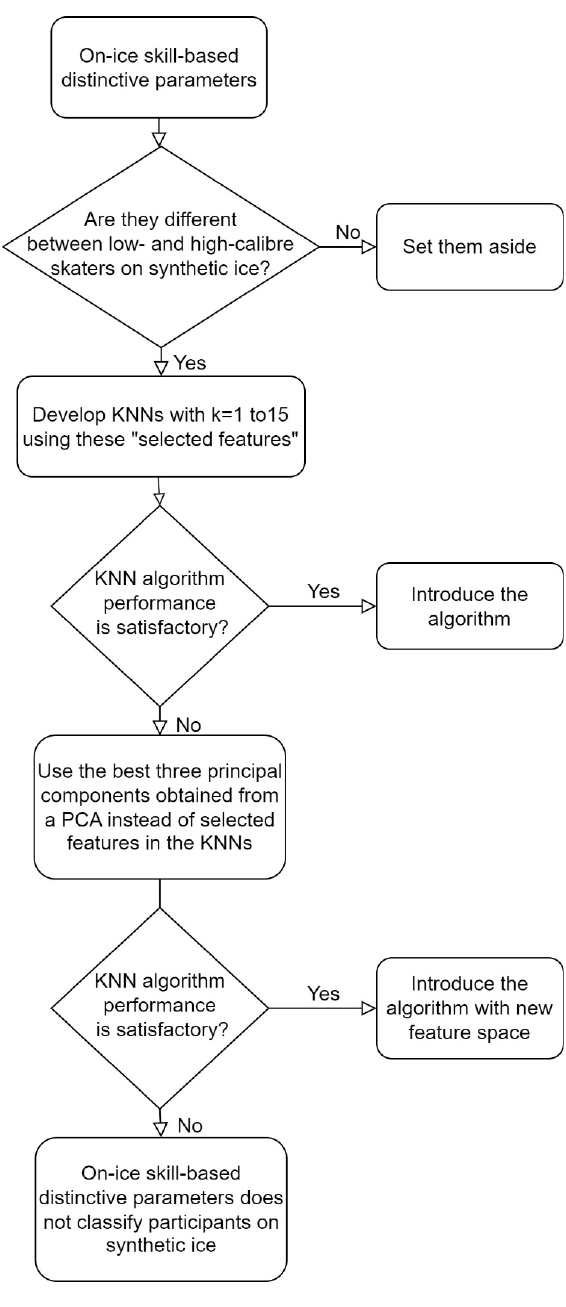
Figure 3. Flowchart of feature selection for KNN algorithms, checking the performance of the algorithms utilizing the selected features or principal components obtained by a PCA.